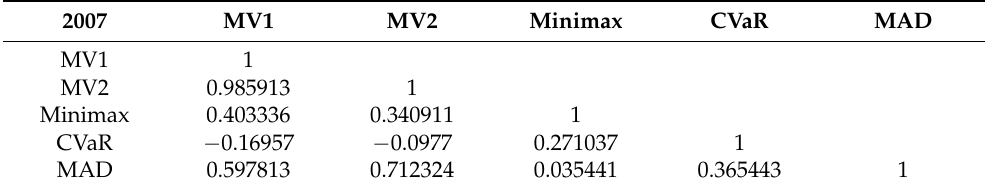
Table A4. Correlation coefficients among portfolio values based on “buy and hold” strategy in